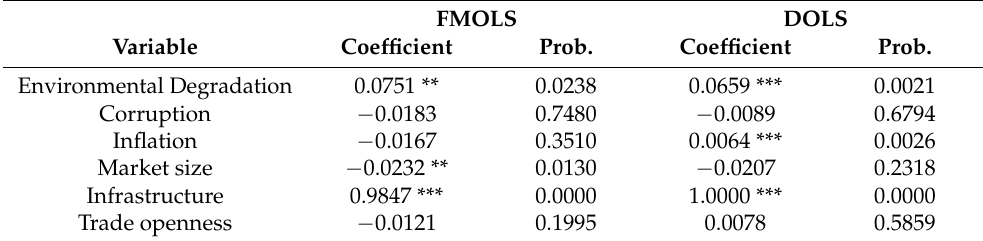
Table 9. Short-run country-specific results. FMOLS DOLS Variable Coefficient Prob. Coefficient Prob. Environmental